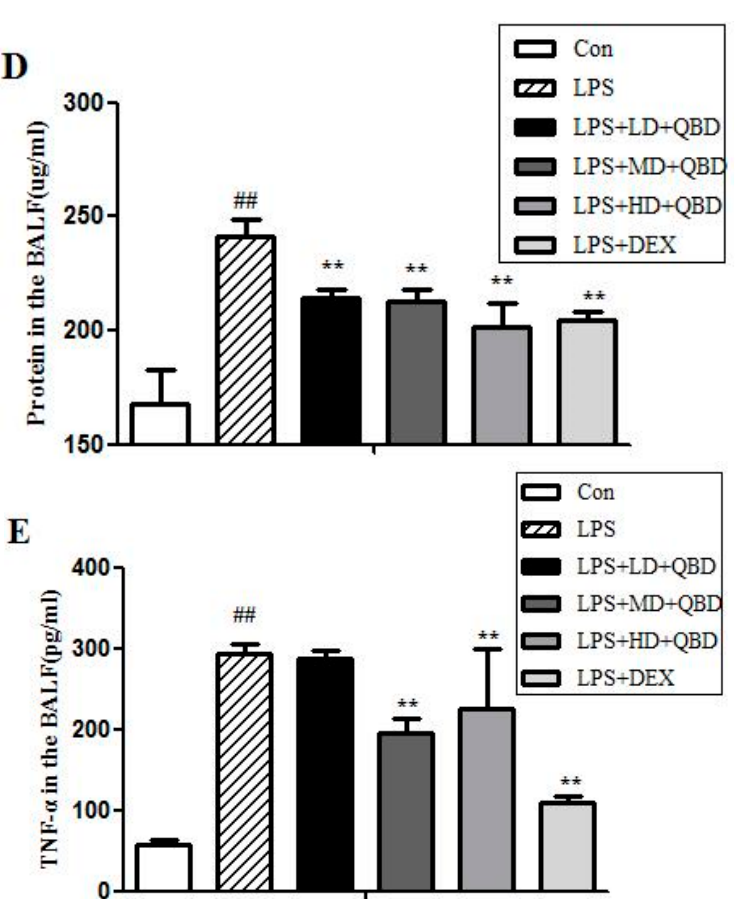
Figure 1. Effects of QBD pretreatment on LPS-induced ALI of the concentrations of inflammatory cytokines and edema in rat. Rats were given by gavage with DEX and different doses of QBD: LD (9.5 g), MD (19 g) and HD (38 g/kg) 24 h and 1 h before intratracheal instillation of LPS (5 mg/kg). Rats were anesthetized at 12 h after LPS challenge and BALF samples were obtained to analyze the inflammatory cytokines. The total leukocyte counts were greater in the LPS group than the control, LD, MD, HD, DEX group ( A ); the PMN counts in the LPS group were higher than the control, LD, MD, HD, DEX group ( B ); the wet/dry weight ratio in the LPS group was greater than the control, MD, HD, DEX group ( C ); the protein concentration was higher in the LPS group than the control, LD, MD, HD, DEX group ( D ) and the TNF- α level was greater in the LPS group than the control, MD, HD, DEX group. Data were presented as means ± SEM ( n = 6). ## p < 0.01 compared to control group; ** p < 0.01 compared to LPS group ( E ).